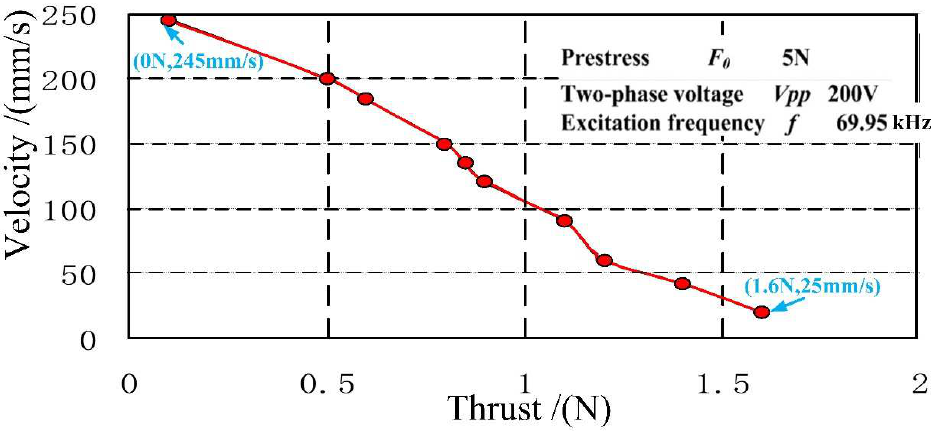
Figure 16. The influence of load on the motor output speed.